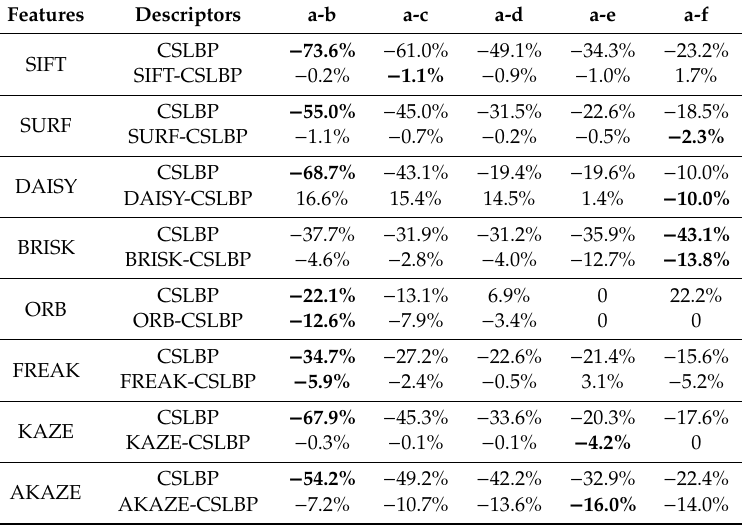
Figure 10. Matching results of the precision of Leuven sequence for the eight original, the CSLBP, and the improved descriptors. The X label represents the matched images of Leuven sequence, and the Y label denotes the precision for each descriptor. ( a ) SIFT features; ( b ) SURF features; ( c ) DAISY features; ( d ) BRISK features; ( e ) ORB features; ( f ) FREAK features; ( g ) KAZE features; and ( h ) AKAZE features. Table 1. The reduced values of recall for the CSLBP and the combined descriptors compared to the original descriptors of Leuven sequence.